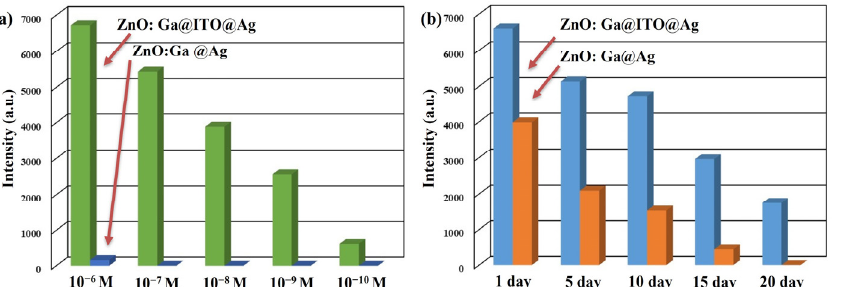
Figure 10. ( a ) The SERS intensities of ZnO: Ga@Ag nanotowers and ZnO: Ga@ITO@Ag nanotowers at 1351 cm − 1 under the different concentrations of amoxicillin solution. ( b ) The SERS intensities of ZnO: Ga@Ag nanotowers and ZnO: Ga@ITO@Ag nanotowers at 1351 cm − 1 under different detection times.